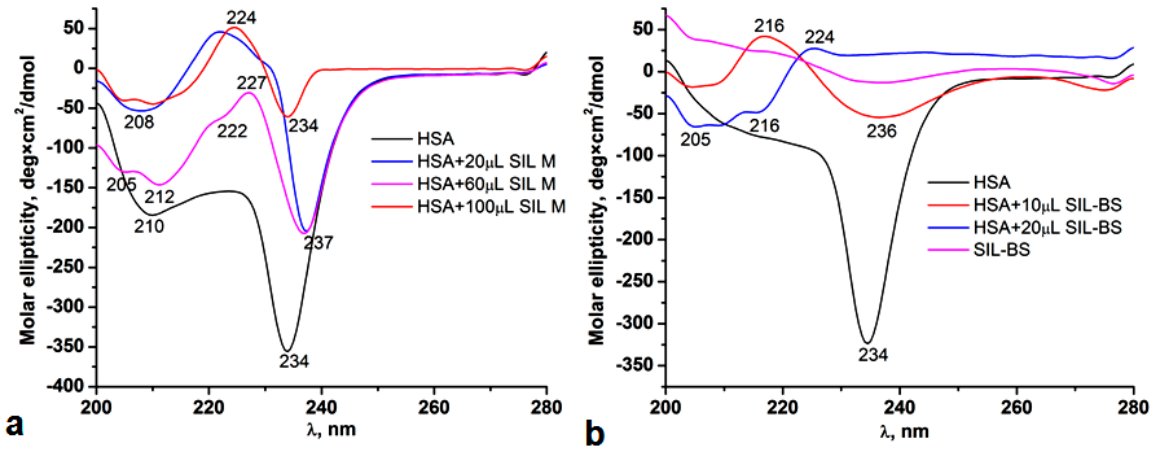
Figure 7. Circular dichroism spectra of SIL M ( a ) and SIL-BS ( b ) in PBS solution of HSA at pH 7.4.